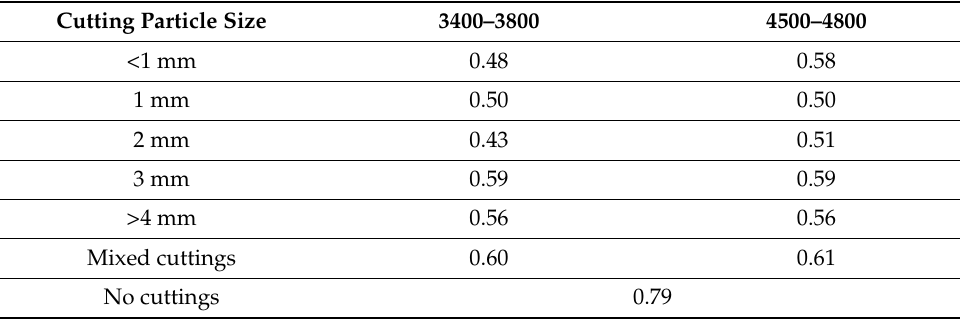
Table 2. Coefficient of friction under casing